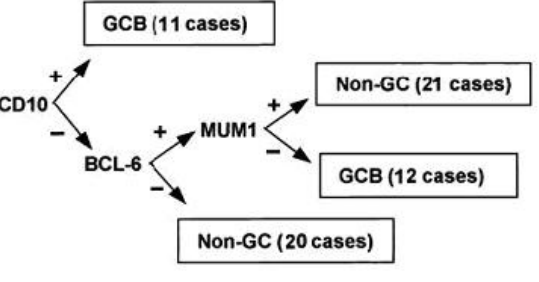
Fig. 1 Decision tree for immunohistochemistry classification of DLBCL (Hans et al. [1]). The immunoperoxidase stained sections were examined by light microscopy. Addi- tional controls omitted the primary antibody. A positive result was rendered if more than 15% of the large atypical cells were unequivocally stained in an expected staining